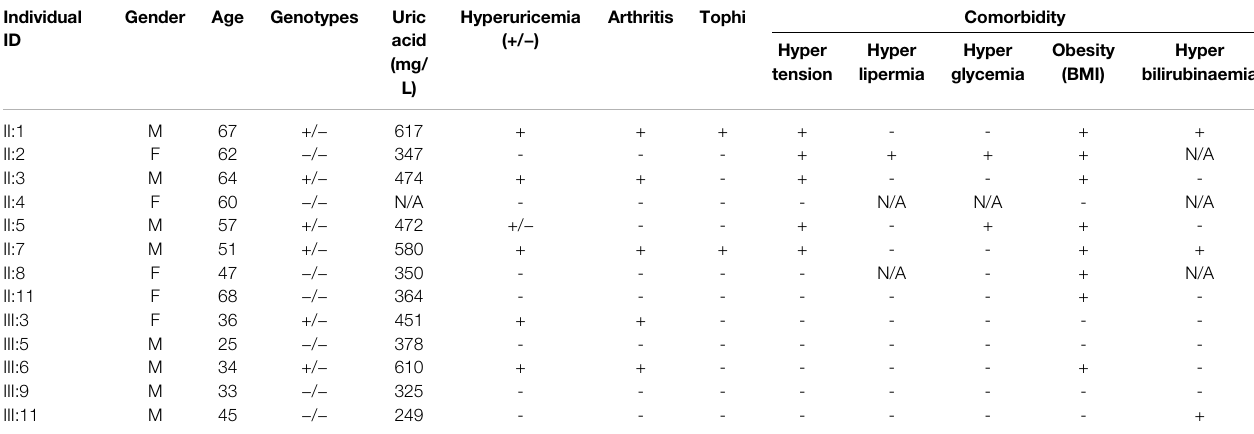
TABLE 1 | Clinical information and genotypes Individual